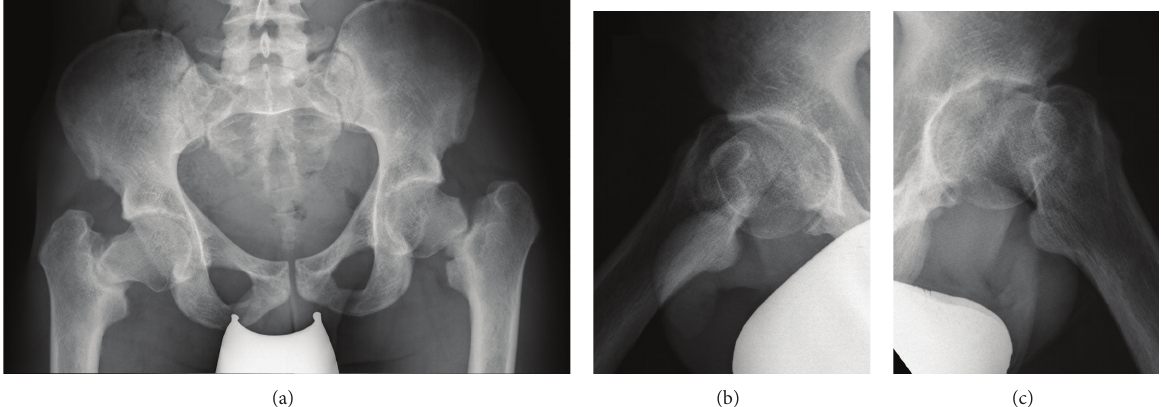
Figure 2: Standard pelvic radiograph showing bilateral pseudarthrosis of the femoral neck (a), axial radiograph of the right hip (b), and axial radiograph of the left hip (c).